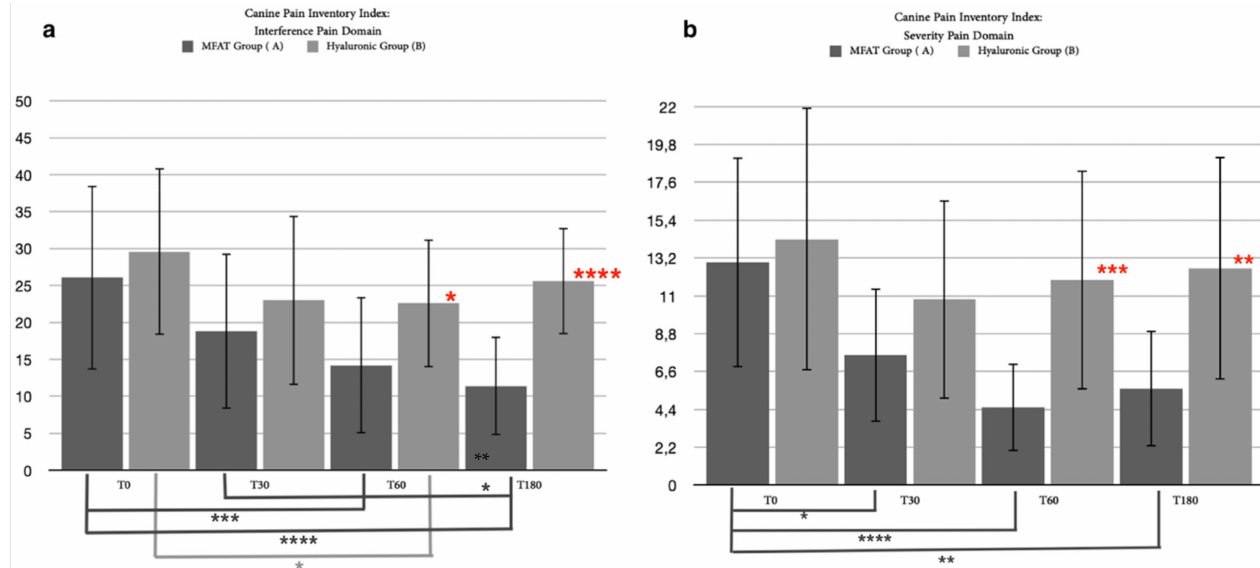
Figure 12. Differences in statistical analysis of data between the hyaluronic group and the MFAT group for ( a ) the CBPI for pain interference after 30 days, 60 days, and 180 days. Red asterisks (*: p = 0.0317; ****: p < 0.0001) indicate significant differences between groups, and group-colored asterisks indicate significant differences within each group (*: p = 0.0335; **: p = 0.0179; ***: p = 0.0002; ****: p < 0.0001; and ( b ) the CBPI for pain severity after 30 days, 60 days, and 180 days. Red asterisks (**: p = 0.0025; ***: p = 0.0004) indicate significant differences between groups, and group- colored asterisks indicate significant differences within each group (*: p = 0.0281; **: p = 0.0011; ****: p <